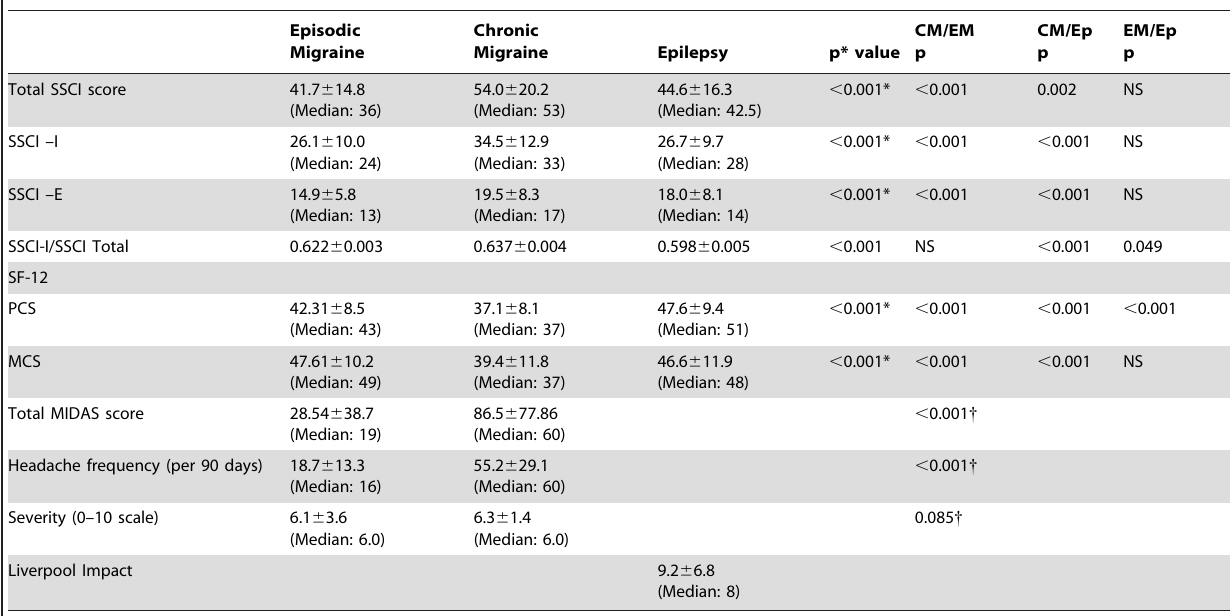
Table 2. Measurements of Stigma, Quality of Life, and Impact.